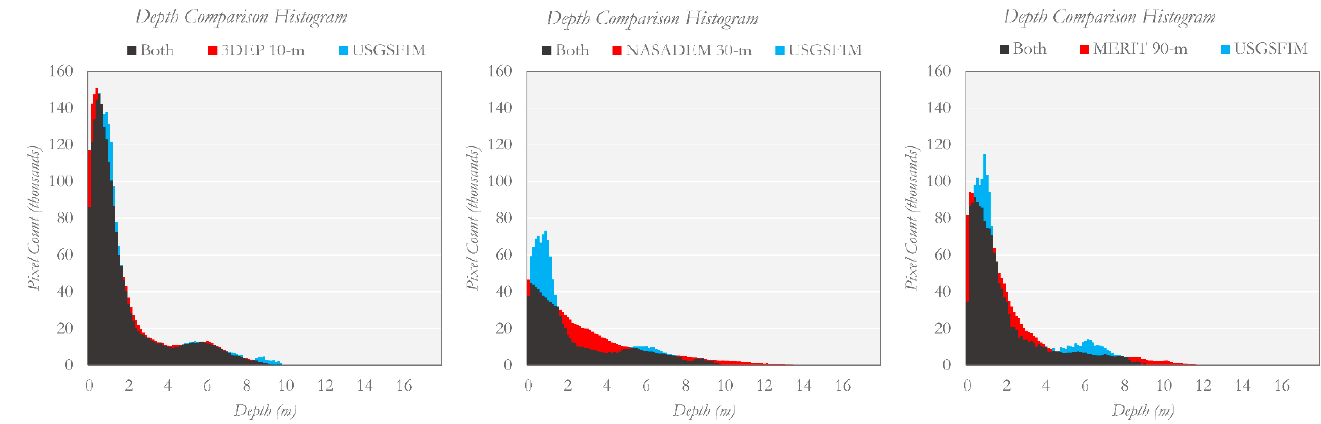
Figure 5. Depth histogram comparisons: 3DEP 10 m, NASADEM 30 m, and MERIT 90 m compared to USGSFIM 5.5 m. Depths were resampled at a 10 m spatial resolution for each dataset so that relative areas are comparable across datasets/charts.